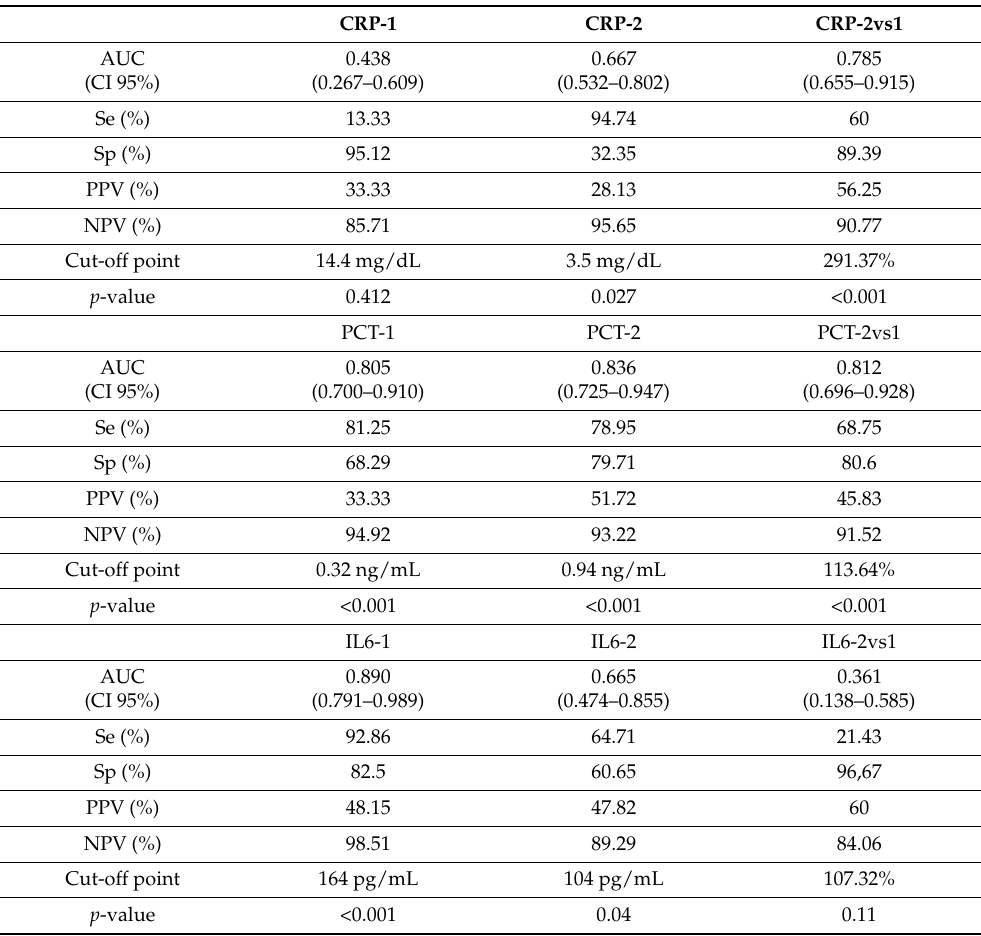
Table 3. Optimal Cut-off points and Accuracy Indicators for CRP, PCT and IL6 to differentiate HRE from